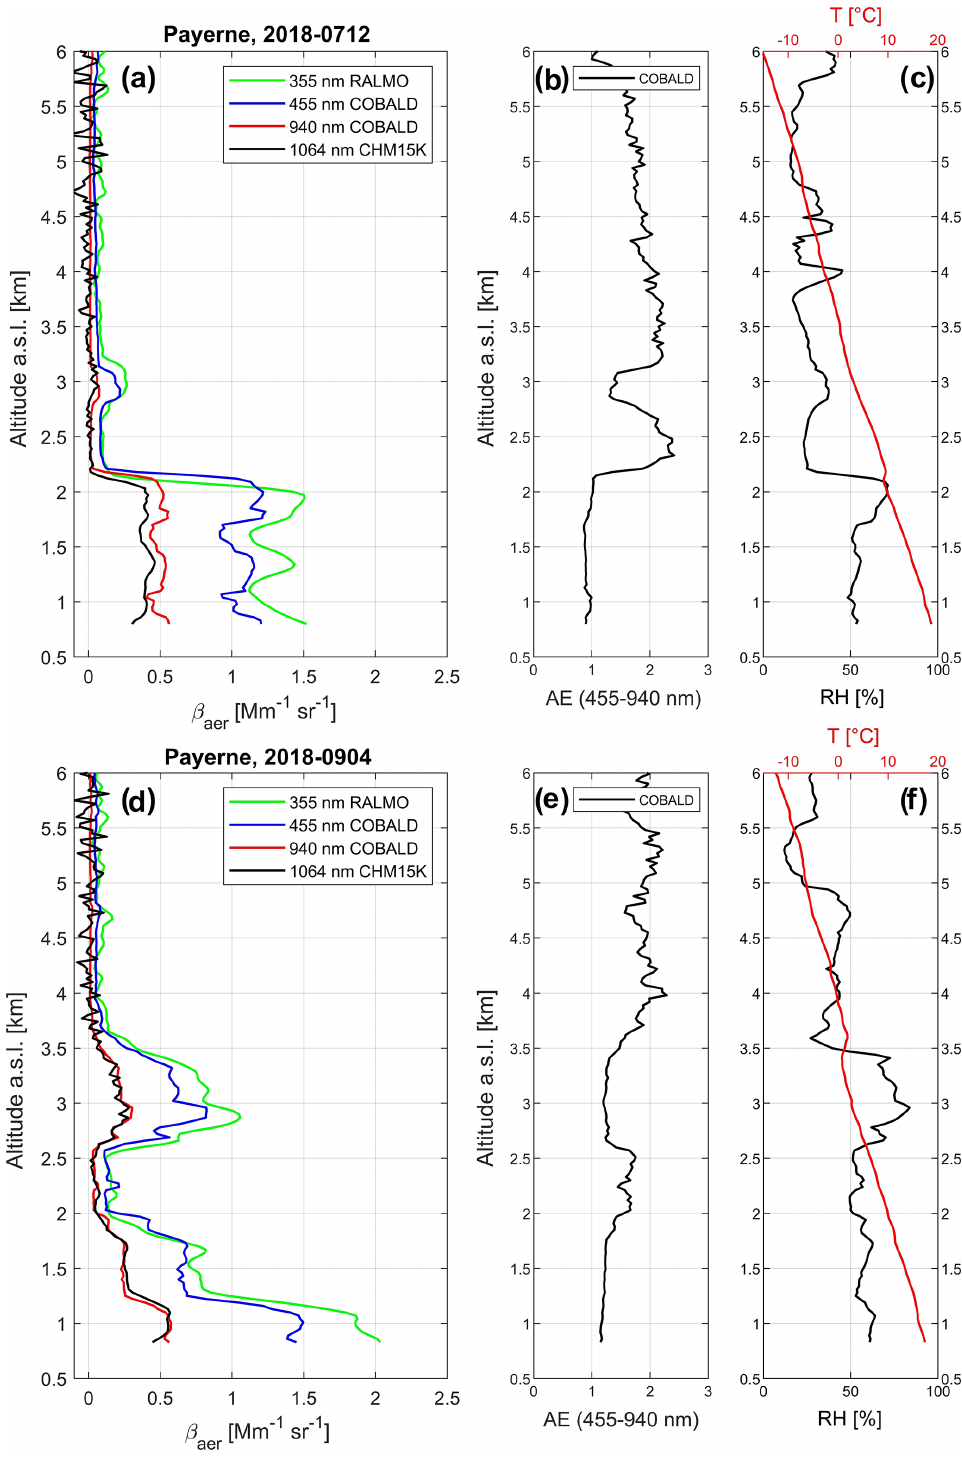
Figure 3. Overview of selected profiles measured on 7 July 2018 (a–c) and 4 September 2018 (d–f) . Panels (a, c) : vertical profiles of aerosol backscatter coefficient ( β aer ) as a function of altitude, measured by RALMO (355nm: green), COBALD (455nm: blue; 940nm: red) and CHM15K (1064nm: black). Panels (b, d) : vertical profiles of Ångström exponent (AE) for wavelengths 455–940nm, calculated from the COBALD data. Panels (c, f) : vertical profiles of relative humidity (RH: black) and temperature (red, top scale) measured by the Vaisala RS41-SGP radiosonde (flying in tandem with the COBALD